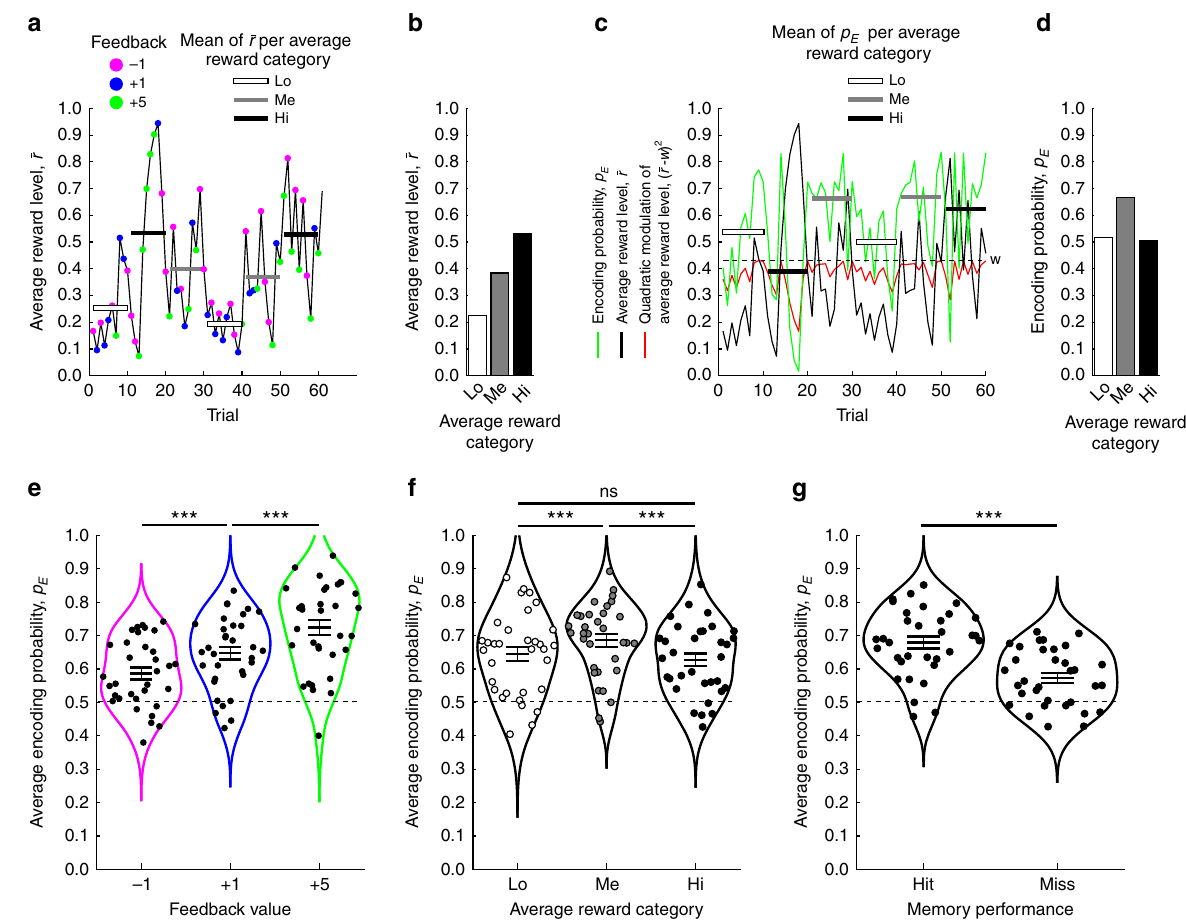
Fig. 2 Computational model. a – d illustrates how parameter values in the computational model derive from the behavioral data, here for one representative participant. a The average reward level ( (cid:1) r , black line) tracks preceding feedback values as an exponential running average. The average (cid:1) r of ten trials within the different average reward categories (Hi, Me, and Lo) are respectively indicated by white, gray, and black bars. b . The average (cid:1) r across average reward categories in ( a ). c When the encoding probability ( p E , green line) is nonlinearly (inverted U-shape) modulated by average reward levels ( (cid:1) r , black line), p E increases when (cid:1) r approaches the optimal level of average reward ( w , dashed line). By contrast, p E decreases whenever (cid:1) r becomes larger or smaller than w . To further illustrate the nonlinear contribution of (cid:1) r to p E , the quadratic term ð (cid:1) r (cid:2) w Þ 2 is displayed as a red line. White, gray, and black bars respectively illustrate the average p E of the ten trials within each average reward category. d The average p E across the average reward categories in ( c ). e Across participants, the most parsimonious model indicates that the encoding probability p E increases monotonically as a function of feedback value, but is nonlinearly modulated by average reward ( f ). g On average the model predicts higher encoding probabilities for subsequent hits as compared with misses. *** p < 0.001, ns not signi fi cant (i.e., p > 0.05), indicates the p value for paired t -test. The horizontal lines in e , f , and g indicate mean ± SEM. Source data are provided as a Source Data fi